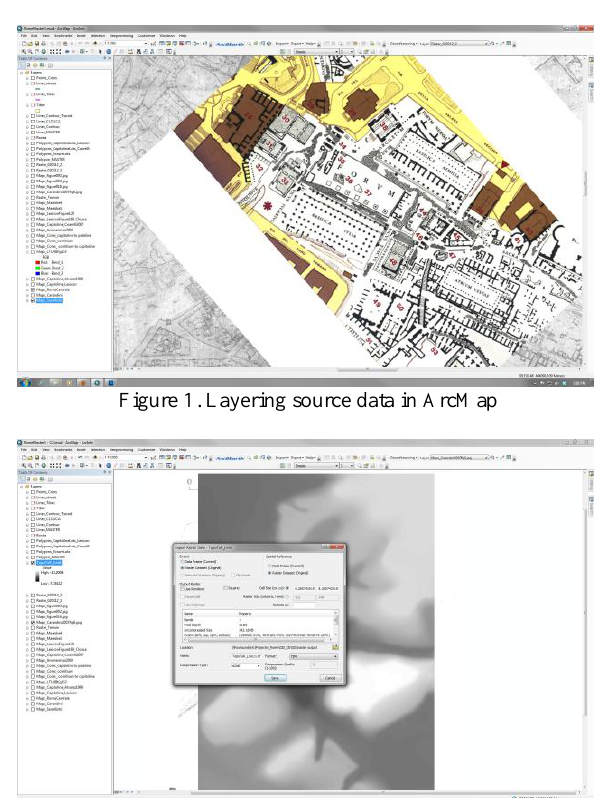
Figure 2. Generating the terrain heightmap raster from GIS data